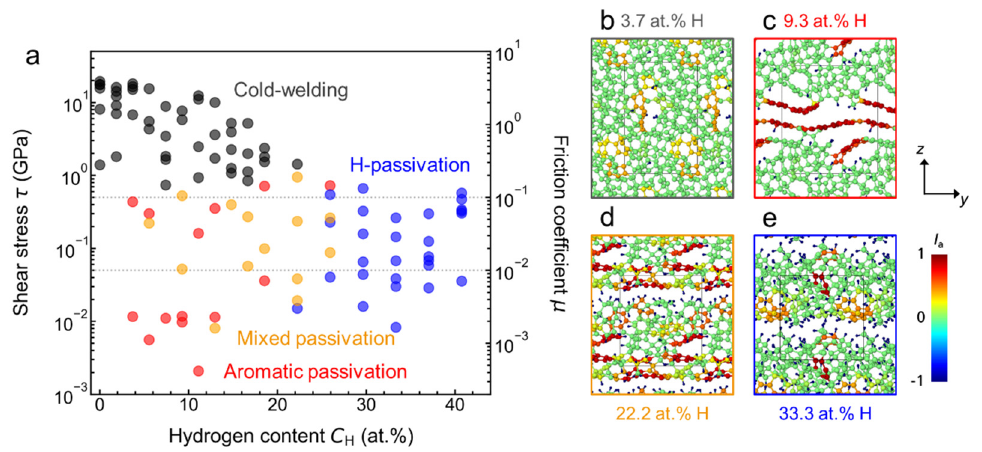
Figure 2. ( a ) Shear stresses τ averaged over the last 0.1 ns and friction regime map of a-C:H with varying hydrogen contents. Each marker represents the result of a MD trajectory and is colored according to the structural analysis described in the main text of Section 3.1. In addition, friction coefficients µ ( = τ / P N ) are given on the right y -axis. Note that these values are meaningful for non-cold-welded regimes only. Two dotted horizontal lines corresponds to µ = 0.01 and 0.1. Representative snapshots for ( b ) cold-welding (CW), ( c ) aromatic, ( d ) mixed, and ( e ) hydrogen passivation regime. All snapshots are side ( yz ) views of the simulation systems. In the panels ( b – e ), the simulation cells are replicated periodically in all directions. The unit cells are indicated by gray rectangles.